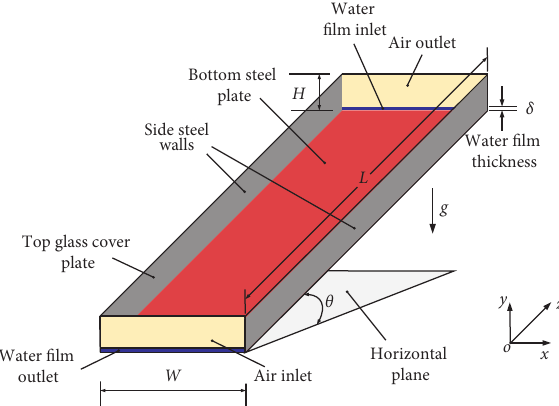
Figure 1: Schematic of 3D computational domain for the rectangular